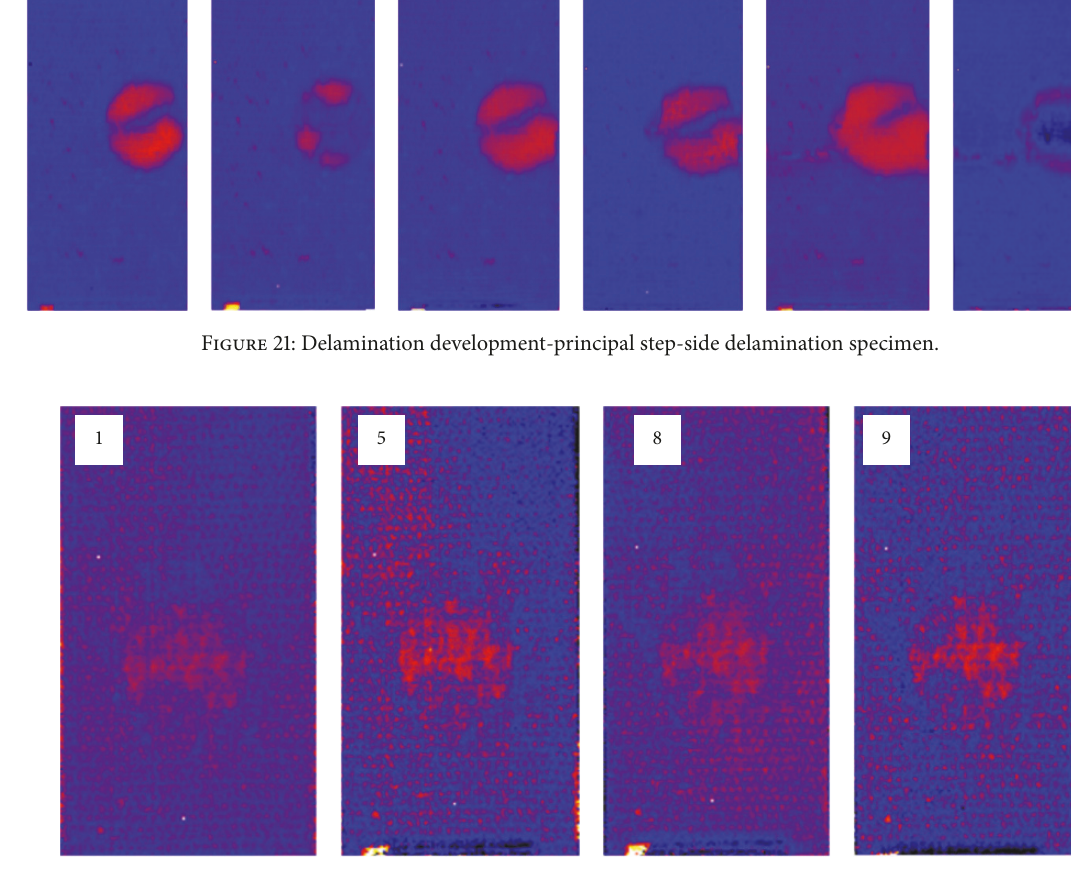
Figure 22: Delamination development-principal step-central delamination specimen.